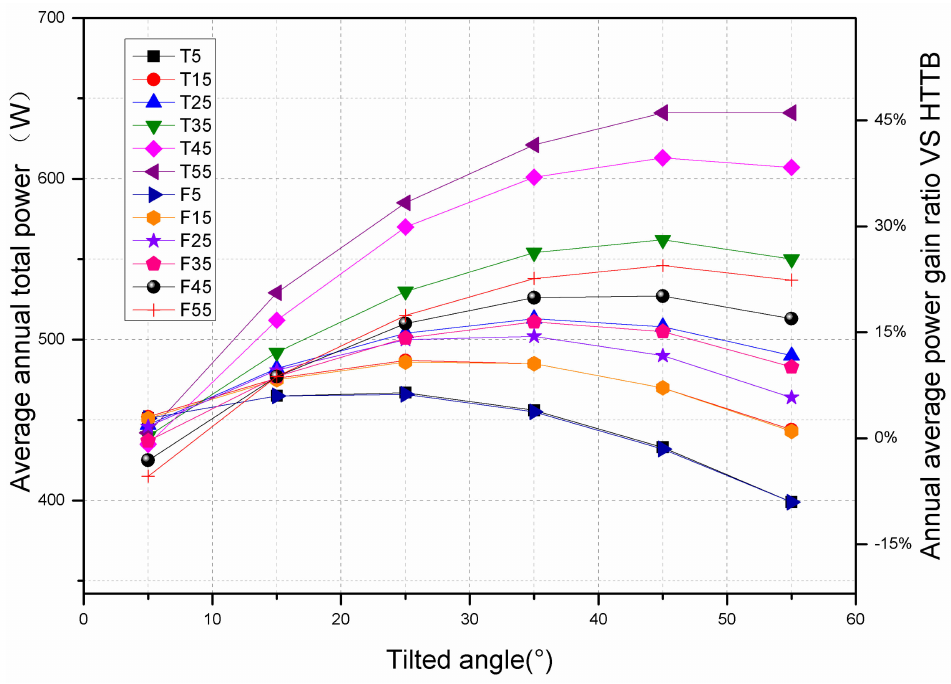
Figure 10. Comparison between total power generation κ ( α , d , h ) _ year of the optimal single-module system and horizontal single tracker with the optimal tilted bifacial